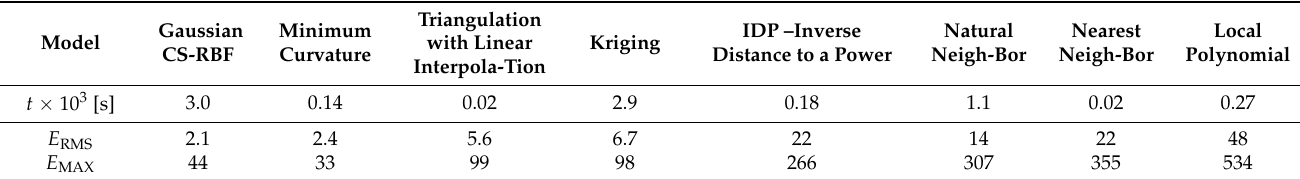
Table 3. Model building times for different RBFs at R 02 = 0.002.